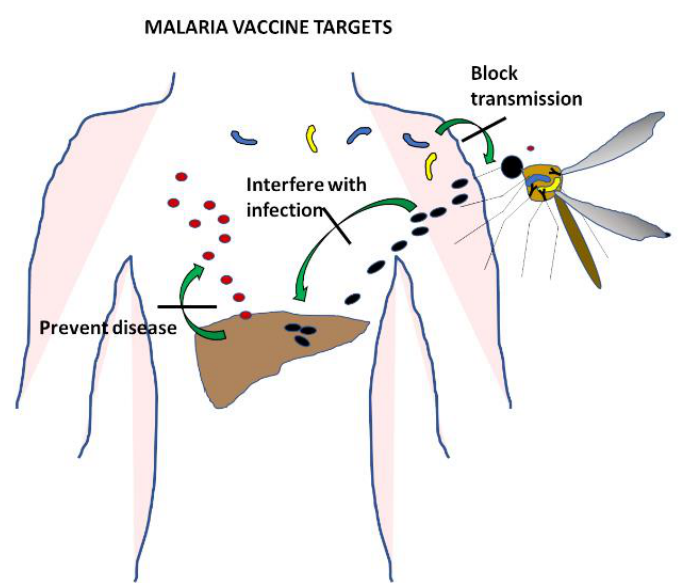
Figure 1. Malaria parasite life cycle. Stages of malaria infection that are the focus of vaccine development. Interfering with the infection of hepatocytes would prevent the disease altogether. Blocking the blood stage would stop clinical symptoms and also prevent transmission of the disease. Targeting gametocytes of early stages in the mosquito would avoid infection spread from person to person without affecting the development of clinical disease.